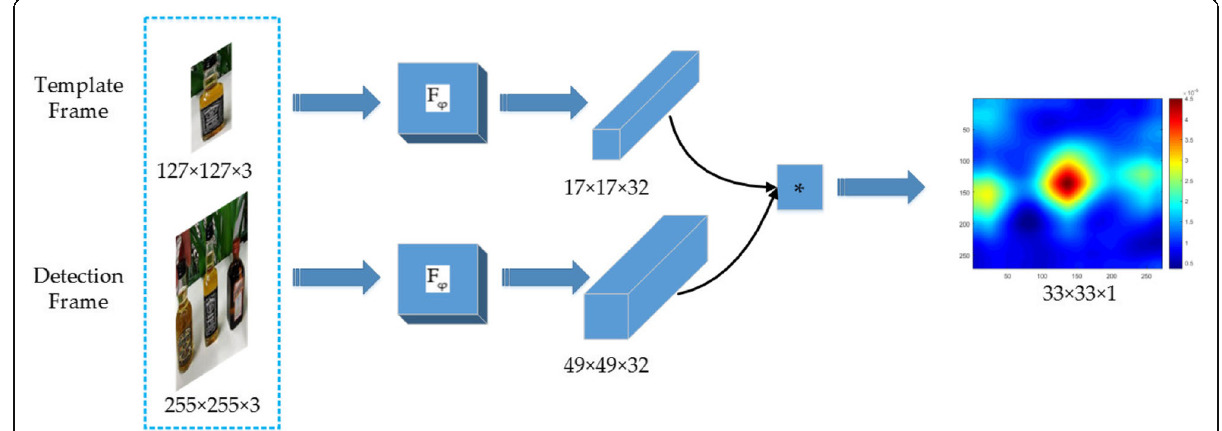
Fig. 3 The structure of SiamFC network. The network utilizes a template patch ( T ) and a larger search region ( S ) as inputs. The embedding function of the Siamese network is a feature extractor F φ , which extracts the features of the template and the search region at the same time. Then, the network feeds the extracted features into the cross-correlation function and gets the final response